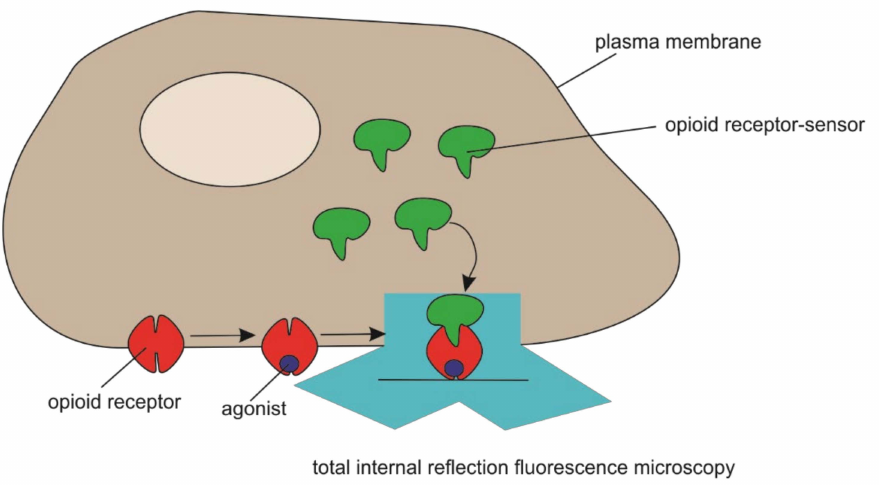
Figure 6. Schematic of opioid receptor-sensor and mu-opioid receptor localization in cells and expected opioid receptor-sensor re-localization upon agonist addition. Total internal reflection fluorescence microscopy light beam is